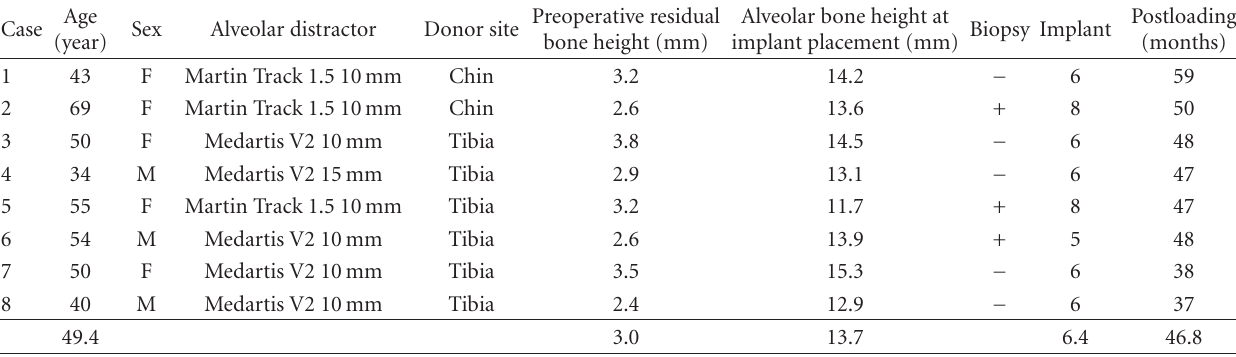
Table 1: Patient profiles and review ( n = 8) of bilateral sinus lifting and simultaneous total alveolar distraction for the edentulous severely atrophic maxilla. Bilateral sinus lifting + Total Alv. DO for edentulous patients.